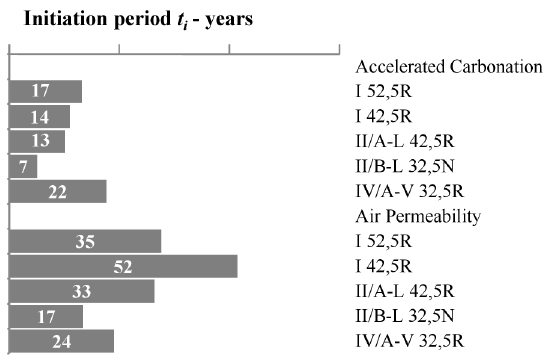
Fig. 3. Design lifetime for target period of 50 years, by accelerated carbonation and air permeability methods, for the exposure class XC2